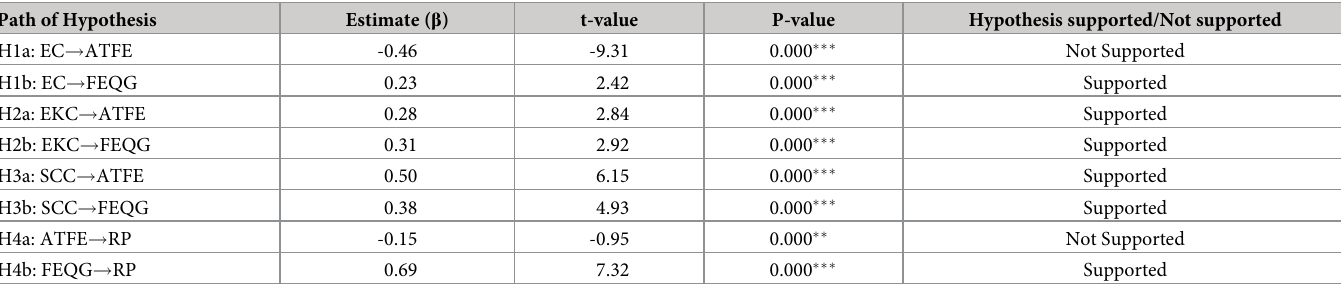
Table 4. Hypotheses